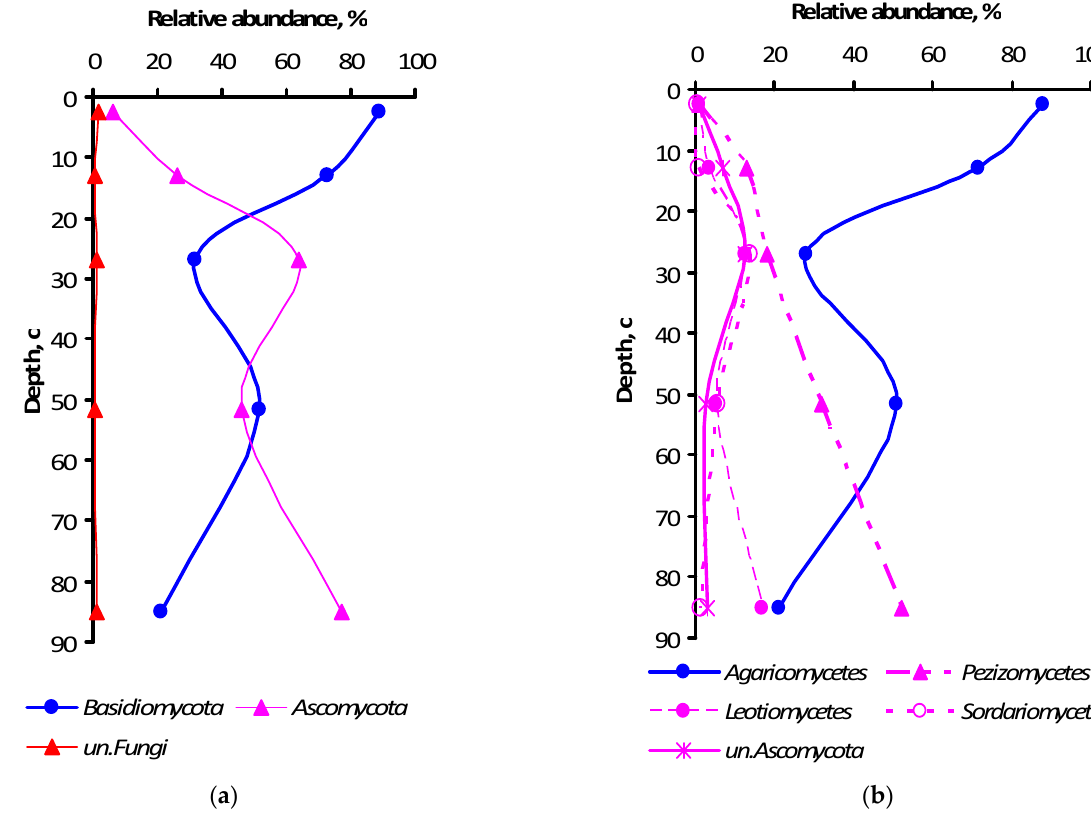
Figure 4. Relative abundance of fungal phylum ( a ) and class ( b ) specific ITS amplicon sequences in genetic horizons of the undisturbed Grey-Luvic Phaeozem under birch forest in the south of West Siberia. The markers show the means of three individual soil samples.